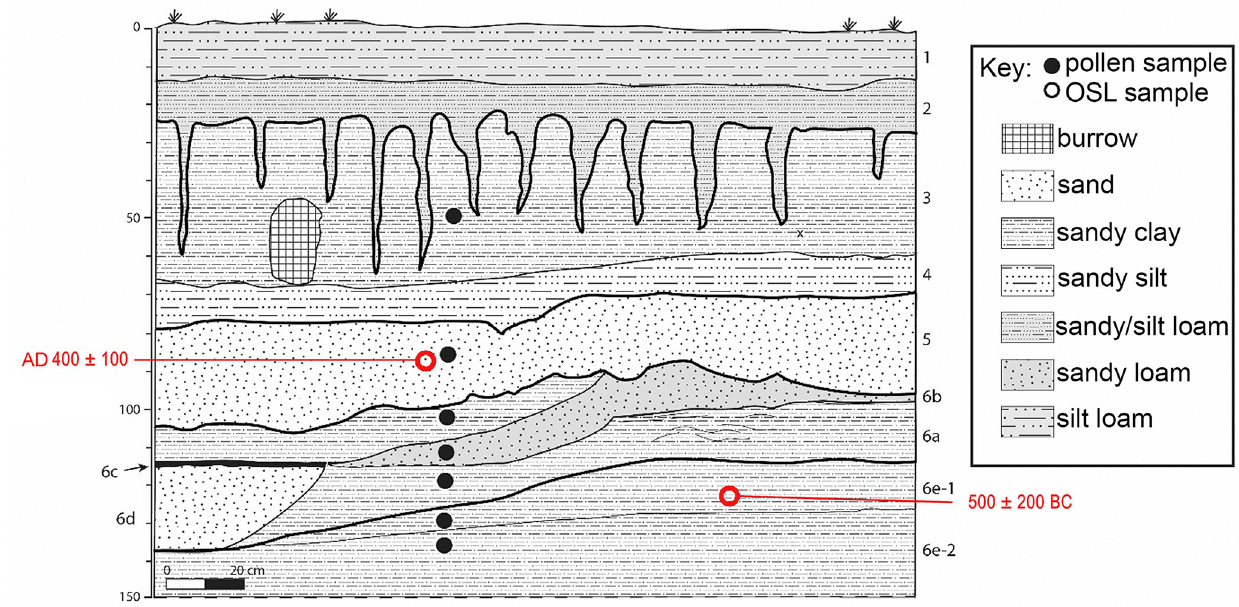
Fig 4. Stratigraphic profile of Operation C-2. (Image created by David Lentz. Reprinted from [19] under a CC BY license, with permission from Vernon L. Scarborough, original copyright 2018). (S2 Table in S1 File) and AMS radiocarbon ( 14 C) analysis (S3 Table in S1 File). These data allowed us to evaluate alternative hypotheses relating to environmental impacts by Ancestral Puebloans at Chaco Canyon. Additional details of our research methods can be found in [33].